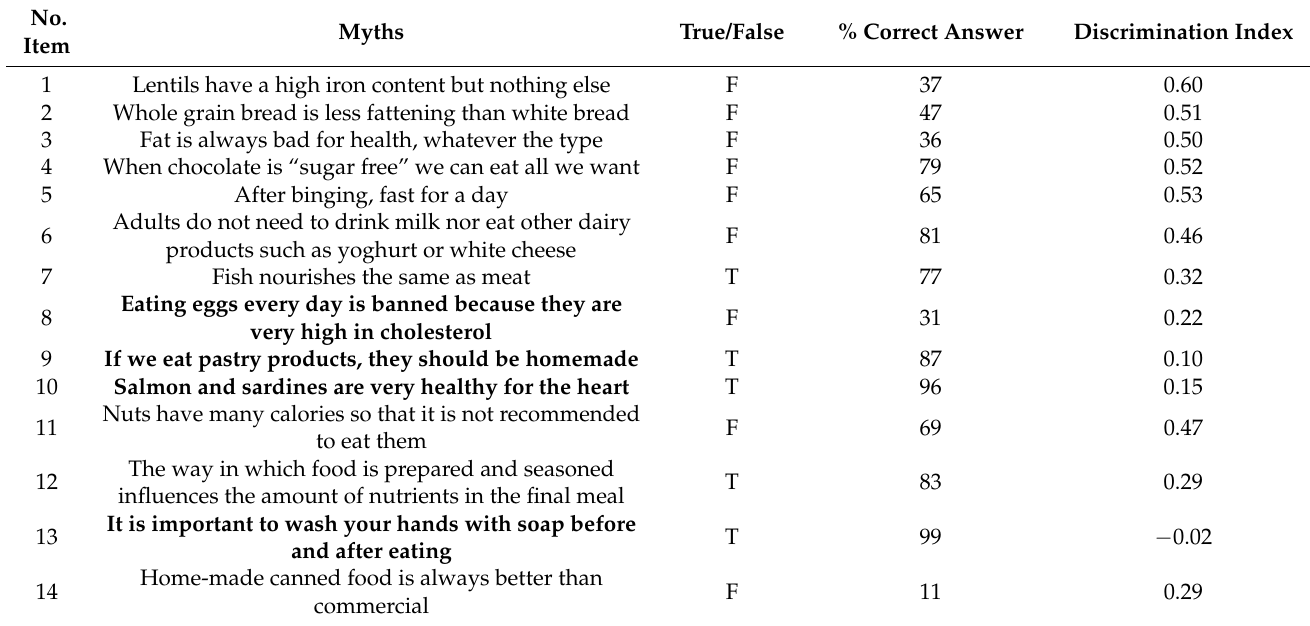
Table 2. List of the preliminary Myths-NL questionnaire with their correct answer, the percentage of respondents answering correctly and the correspondent discrimination index ( n =